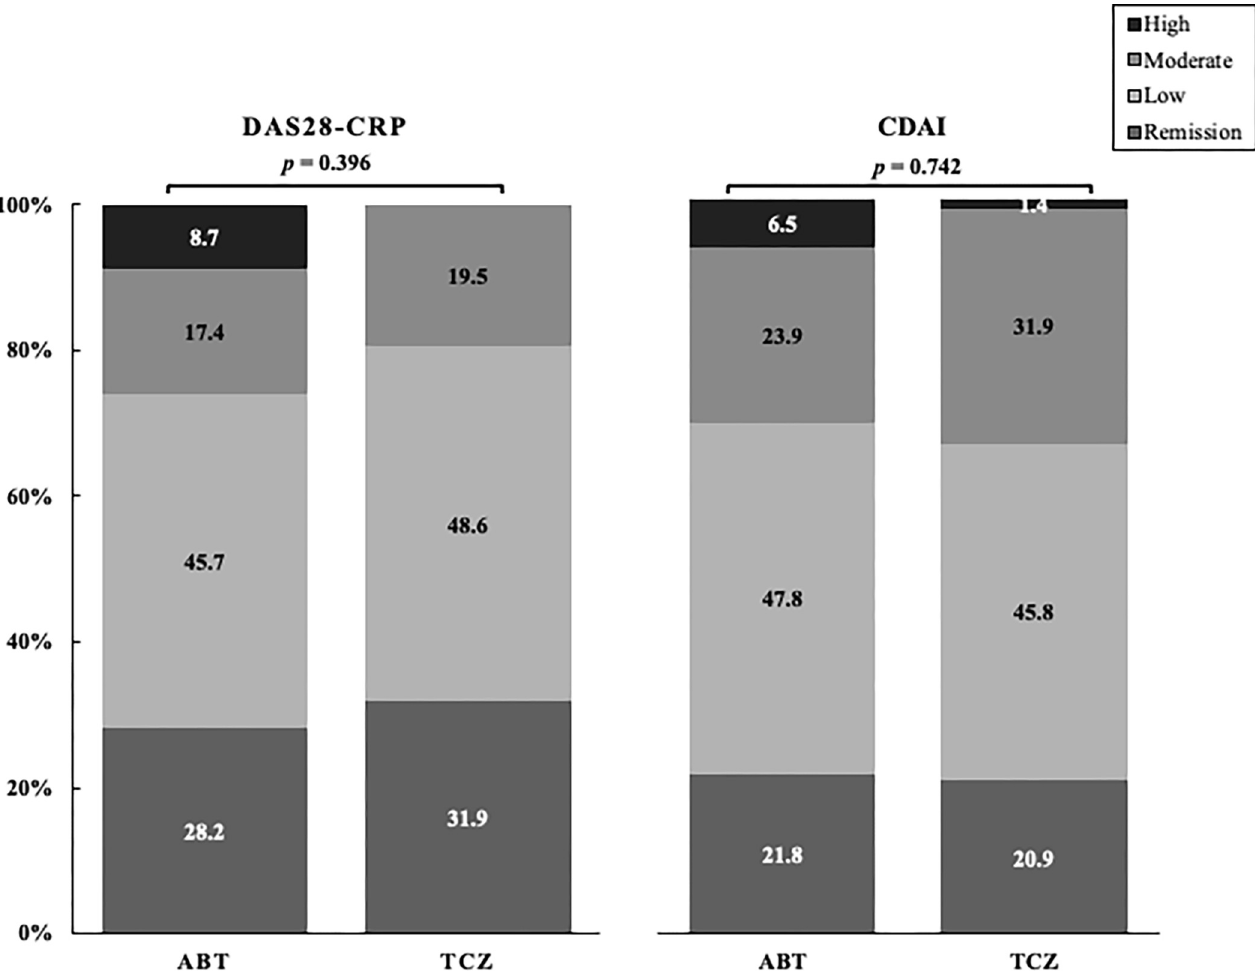
Fig 2. Proportions of patients who archived LDA or remission based on a DAS28-CRP or CDAI between elderly patients initiating with ABT and TCZ at 24 weeks. Disease activity was classified into four categories as HDA, MDA, LDA, remission based on DAS28-CRP and CDAI. There was no significant difference in the proportions of archiving LDA or remission between elderly patients initiating with ABT or TCZ.